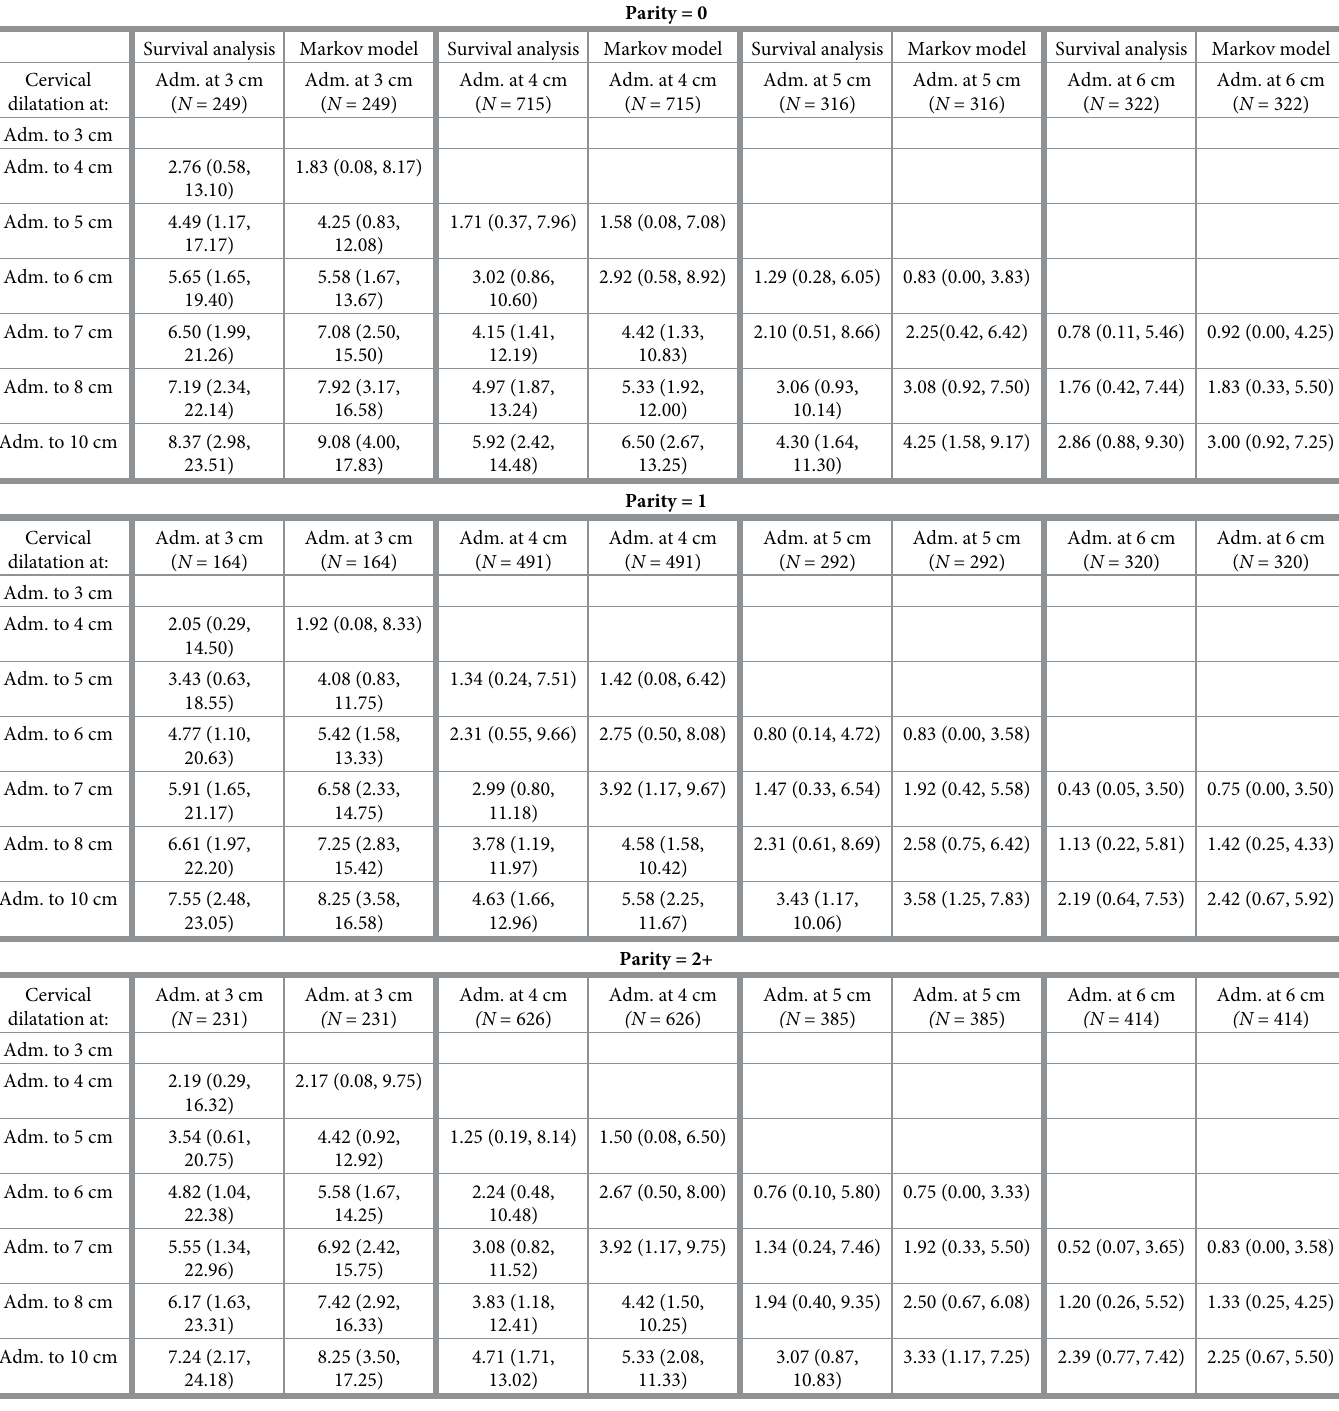
Table 3. Cumulative duration of labour in Para 0, 1, and 2+ based on the cervical dilatation at